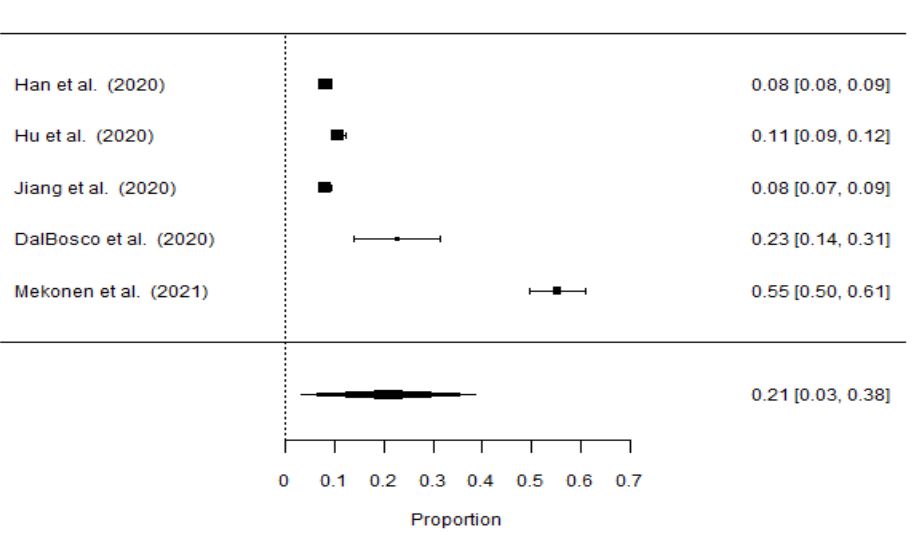
Figure 2. Forest plot for the prevalence of depression among nurses: ( A ) overall result; ( B ) assessment scale PHQ-9; ( C ) remaining assessment scales, excluding PHQ-9.